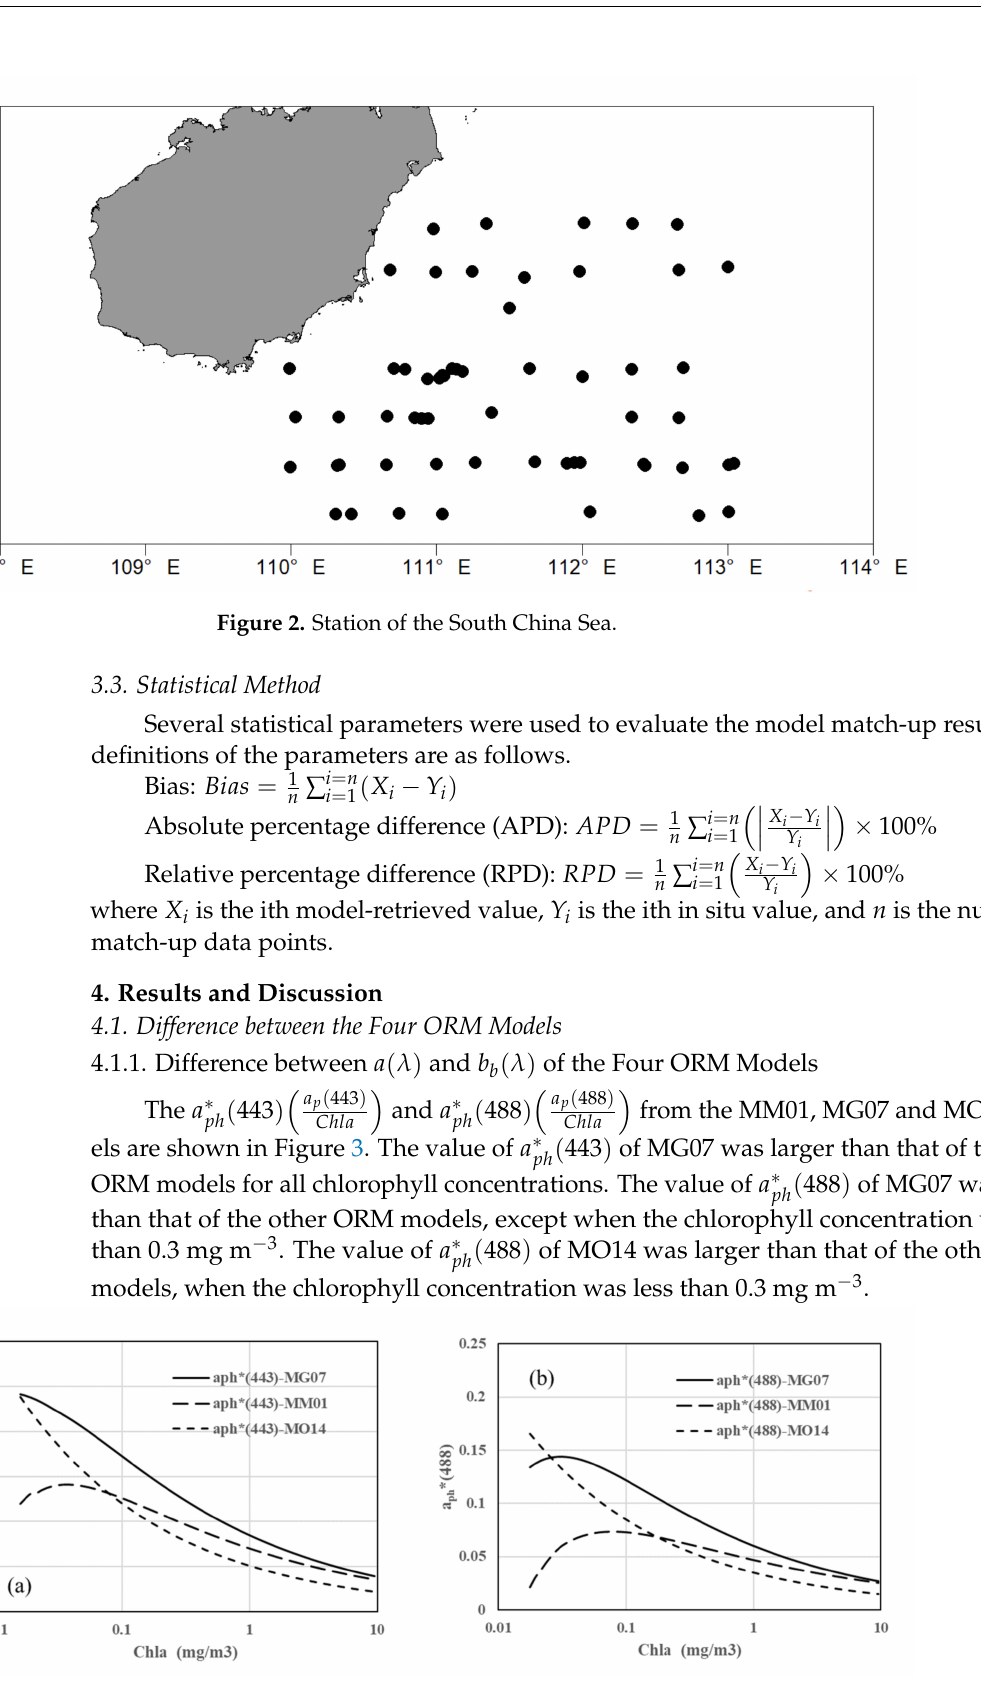
( 443 ) and a ∗ ( 488 ) of MM01, MG07 and MO14 models with the concentration of chlorophyll. (( a ) is Figure 3. The a ∗ ph ph ( 443 ) , ( b ) is a ∗ ( 488 ) a ∗ ph ph